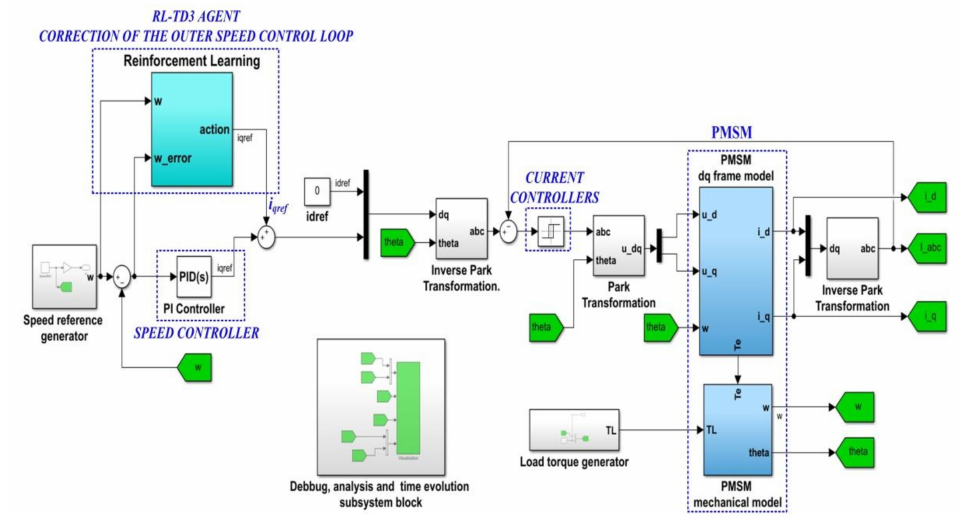
Figure 5. Block diagram of the MATLAB/Simulink implementation for the PMSM control based on PI-type controllers using the RL-TD3 agent for the correction of i qref .